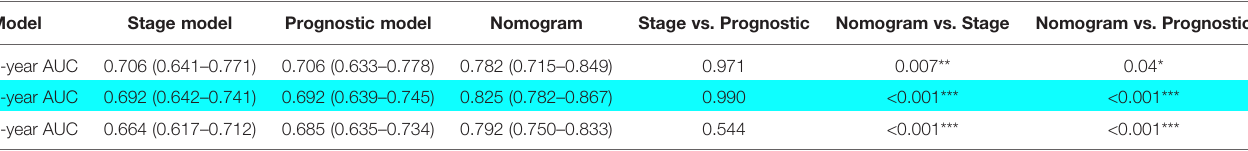
TABLE 1 | Comparison of the AUC values between stage model, prognostic model, and the nomogram. Model Stage model Prognostic model Nomogram Stage vs. Prognostic Nomogram vs. Stage Nomogram vs. Prognostic